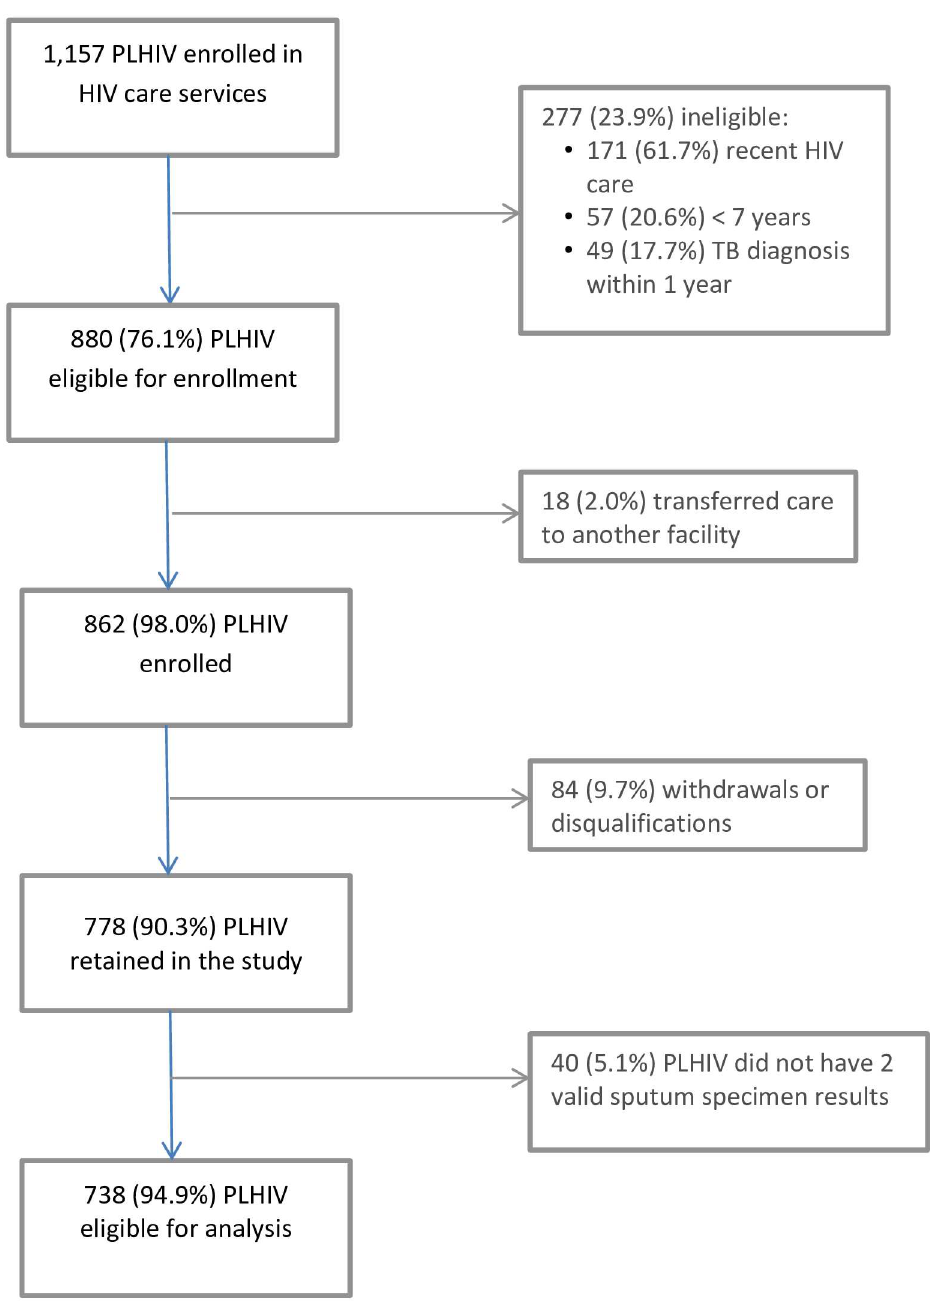
Fig 1. Flow Diagram Showing Numbers of People Living with HIV (PLHIV) Screened, Eligible, Enrolled, and Included in the